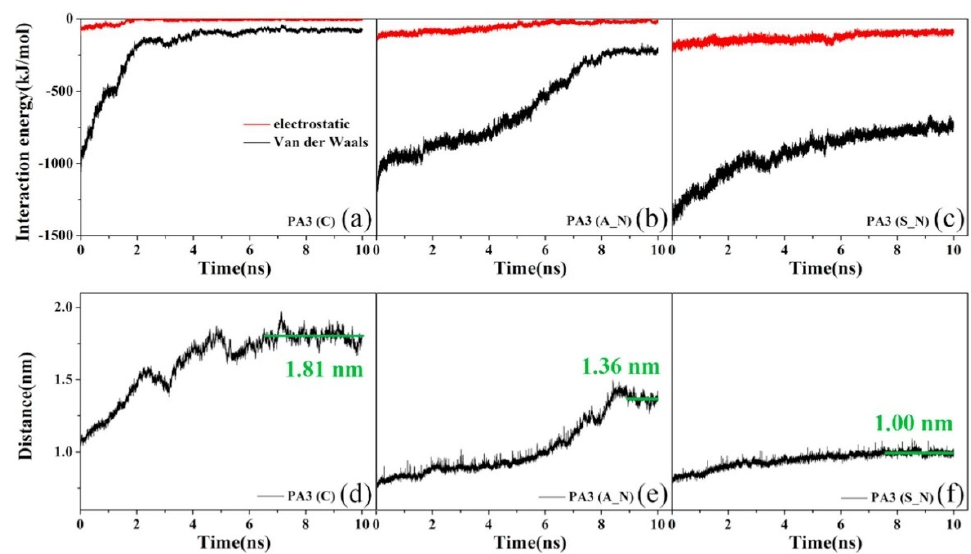
Figure 24. The interaction energies between asphaltenes ( a ) PA3 (C), ( b ) PA3 (A_N), ( c ) PA3 (S_N) and silica as a function of simulation time; average distance between center of mass (COM) of asphaltenes, ( d ) PA3 (C), ( e ) PA3 (A_N), ( f ) PA3 (S_N) and silica as a function of simulation time. Reprinted with permission from Ref. [200]. Copyright 2019, copyright the Elsevier. More details on Copyright and Liscensing are available via the following link: https://linkinghub.elsevier.com/.